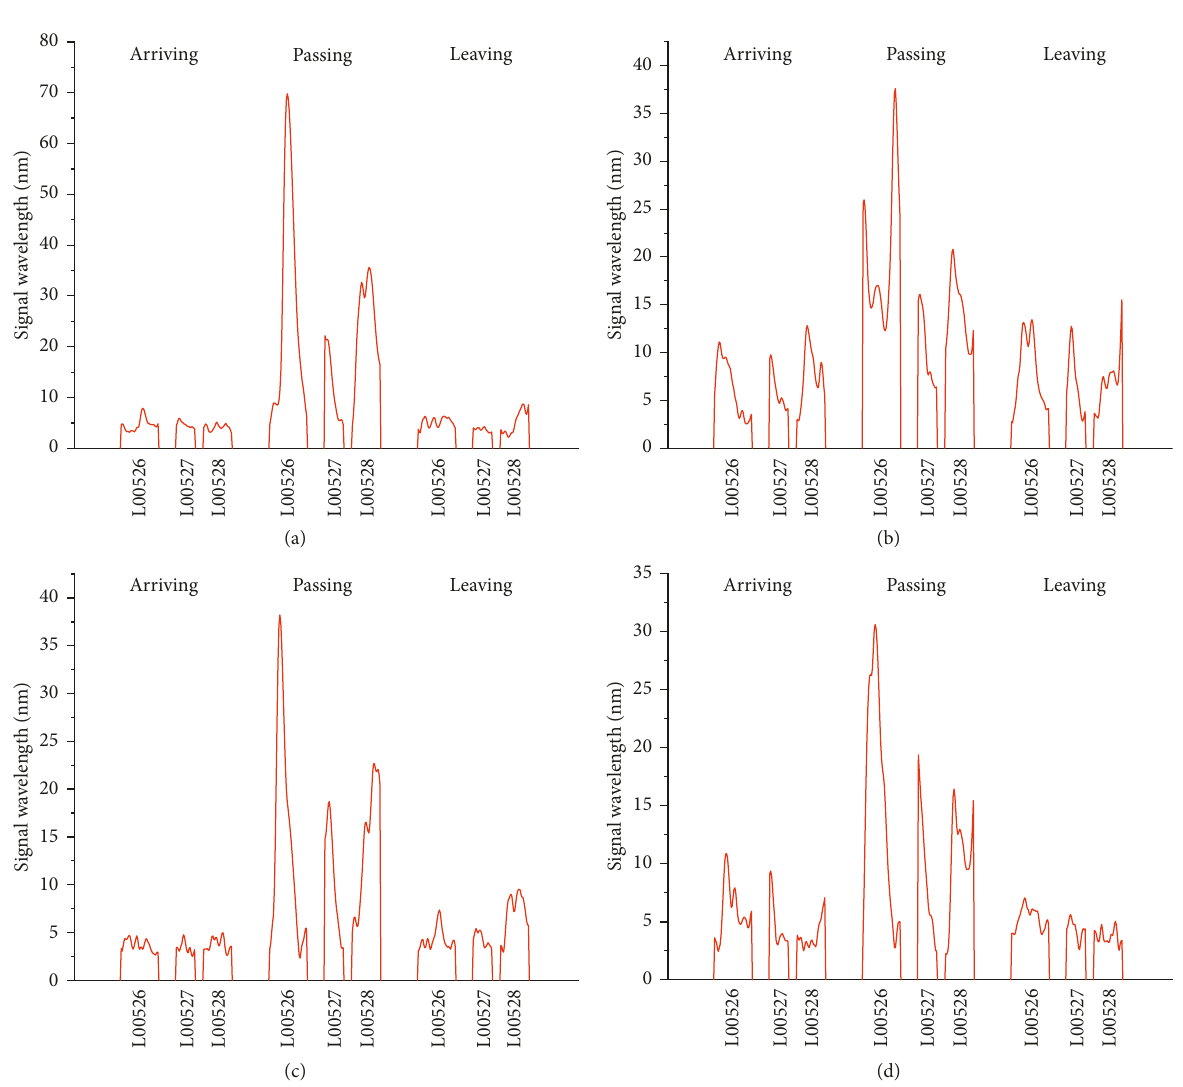
Figure 14: Vibration signal of the right track line before L00526 repair: (a) 1 st train; (b) 2 nd train; (c) 3 rd train; (d) 4 th